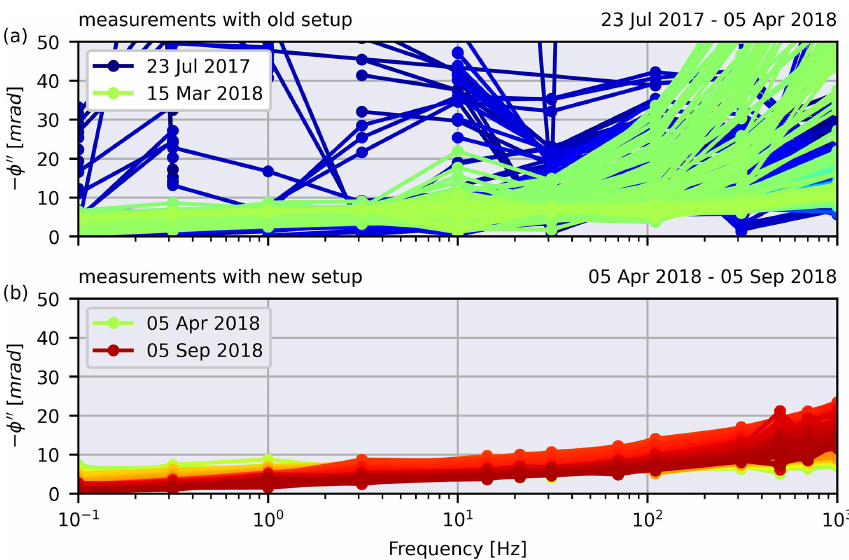
Figure 11. Raw phase spectra for the electrode configuration a = 1, b = 20, m = 3, n = 22 between 23 July 2017 and 5 September 2018. (a) Spectra measured using the first electrode and cable setup. (b) Spectra measured using the second, improved, electrode and cable setup. Measurements are not corrected for inductive effects.